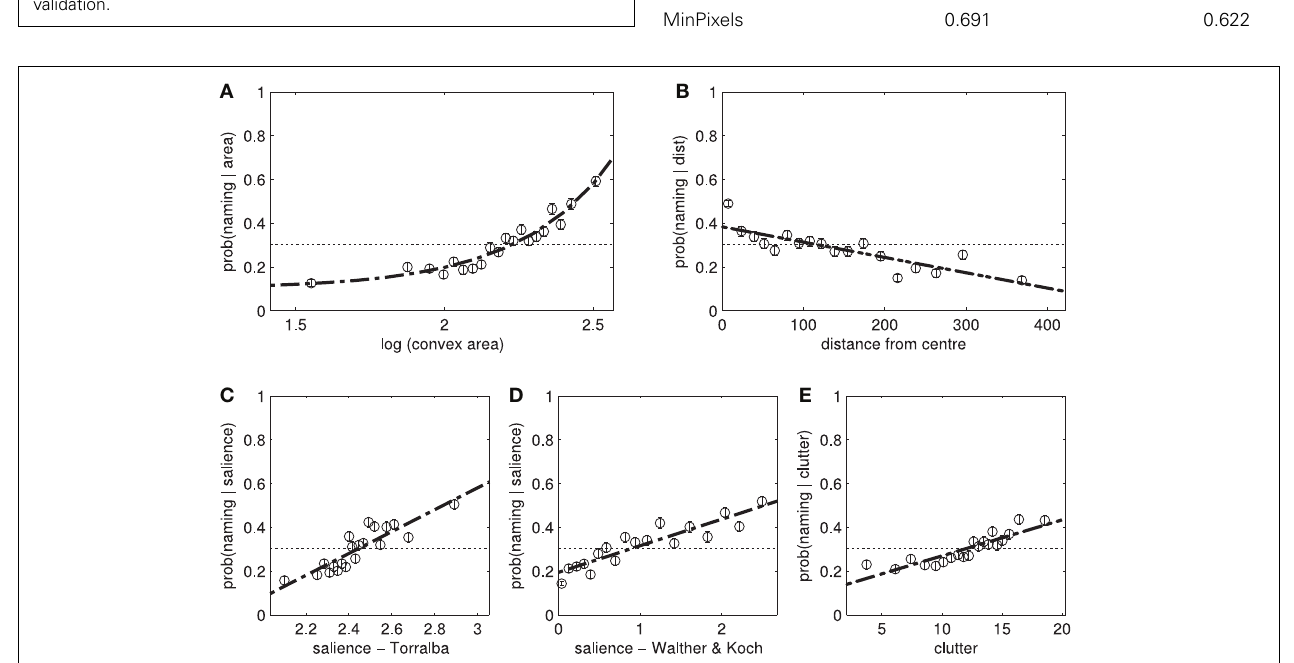
FIGURE 4 | The effect of individual features on the likelihood of naming an object. Participants are more likely to name (A) large, (B) central items. (C,D) Salient items and (E) those with a high clutter score are also more likely to be named. These features have a similar effect on fixation locations.